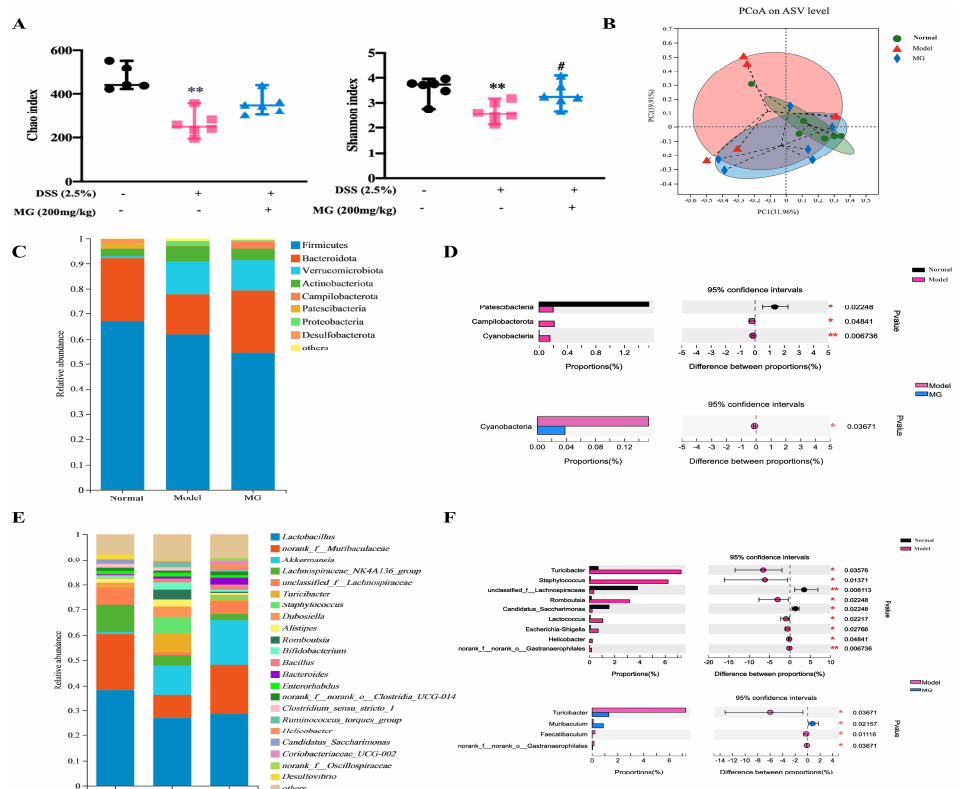
Figure 7. 16S rRNA sequencing for the impact of MG on gut microbiota detection. ( A ) Alpha diversity indexes of each group ( n = 6, ** p < 0.01 vs. the normal group; # p < 0.05 vs. the DSS group). ( B ) β -diversity evaluated using weighted UniFrac-based PCoA. ( C , D ) Relative abundances of microbiota constituents at the phylum level. * p < 0.05, ** p < 0.01. ( E , F ) Relative abundances of microbiota constituents at the genus level. * p < 0.05, ** p <